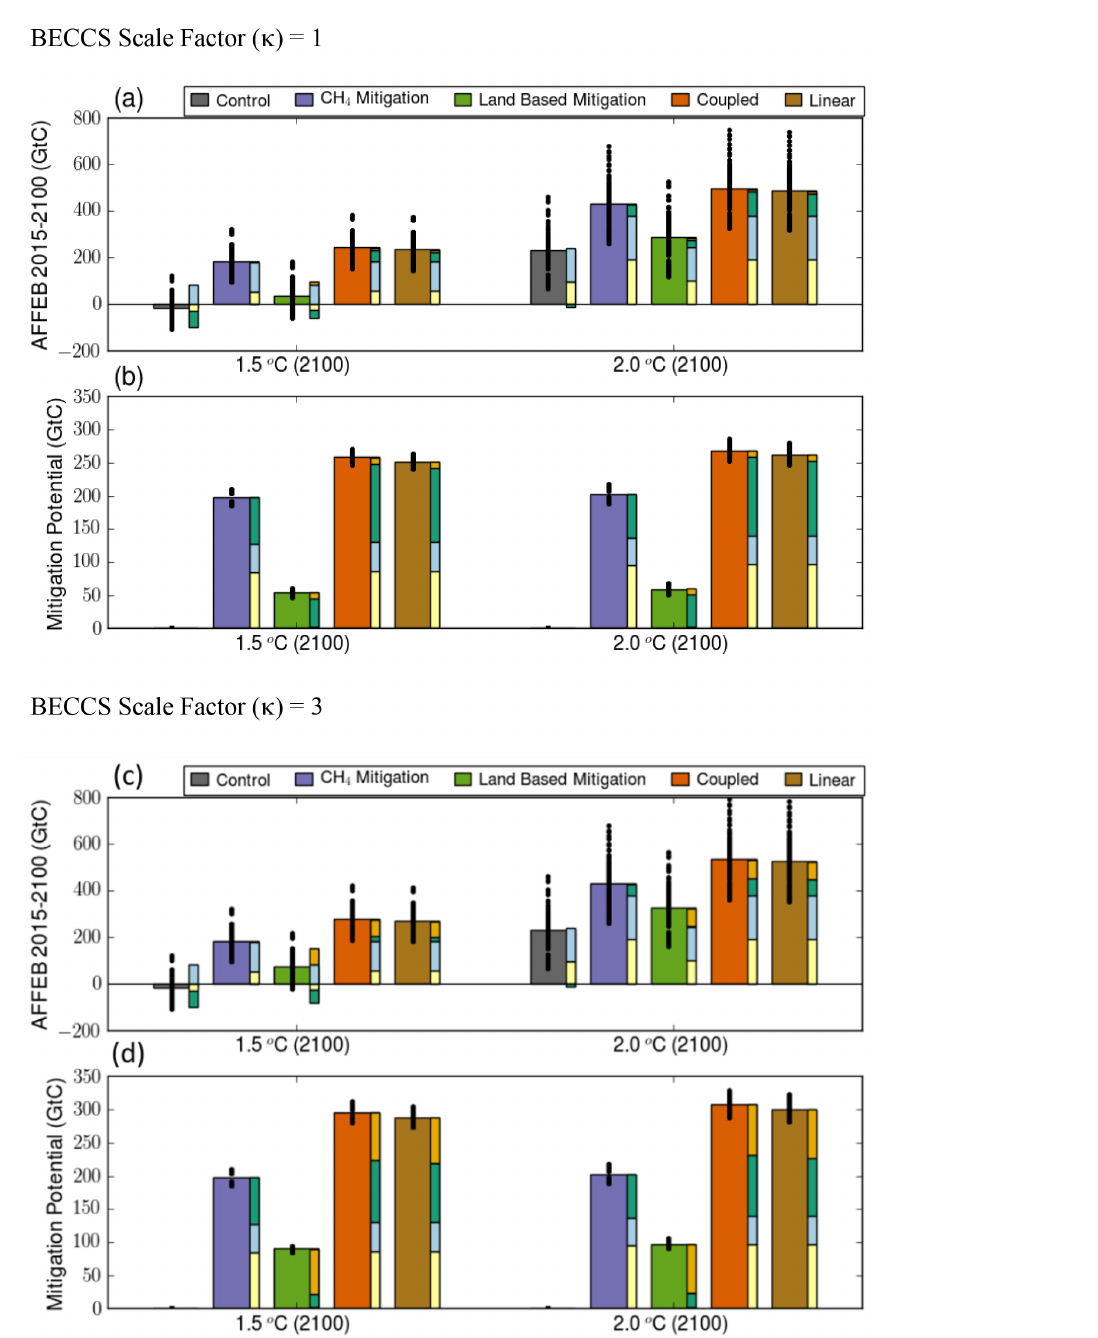
Figure 9. (a, c) The allowable anthropogenic fossil fuel emission budgets (AFFEBs; GtC) for the control (grey), CH 4 mitigation (purple), land-based mitigation (green), coupled methane and land-based mitigation (orange), and the linearly summed methane and land-based mit- igation (brown) for two temperature pathways asymptoting at 1.5 ◦ C (left) and 2.0 ◦ C (right). (b, d) The mitigation potential (GtC) as the increase in AFFEB from the corresponding control run. The breakdown of each AFFEB and mitigation potential by the changes in the carbon stores is also shown: atmosphere (pale yellow), ocean (light blue), land (dark green), and BECCS (gold) is included alongside each bar. Note that the land carbon store for the CH 4 scenario at − 1 . 4GtC (median of ensemble) is not visible. There has, however, been a net increase in the land carbon store in this scenario when compared to the land carbon store in the control run ( − 70 . 8GtC, median of ensemble).